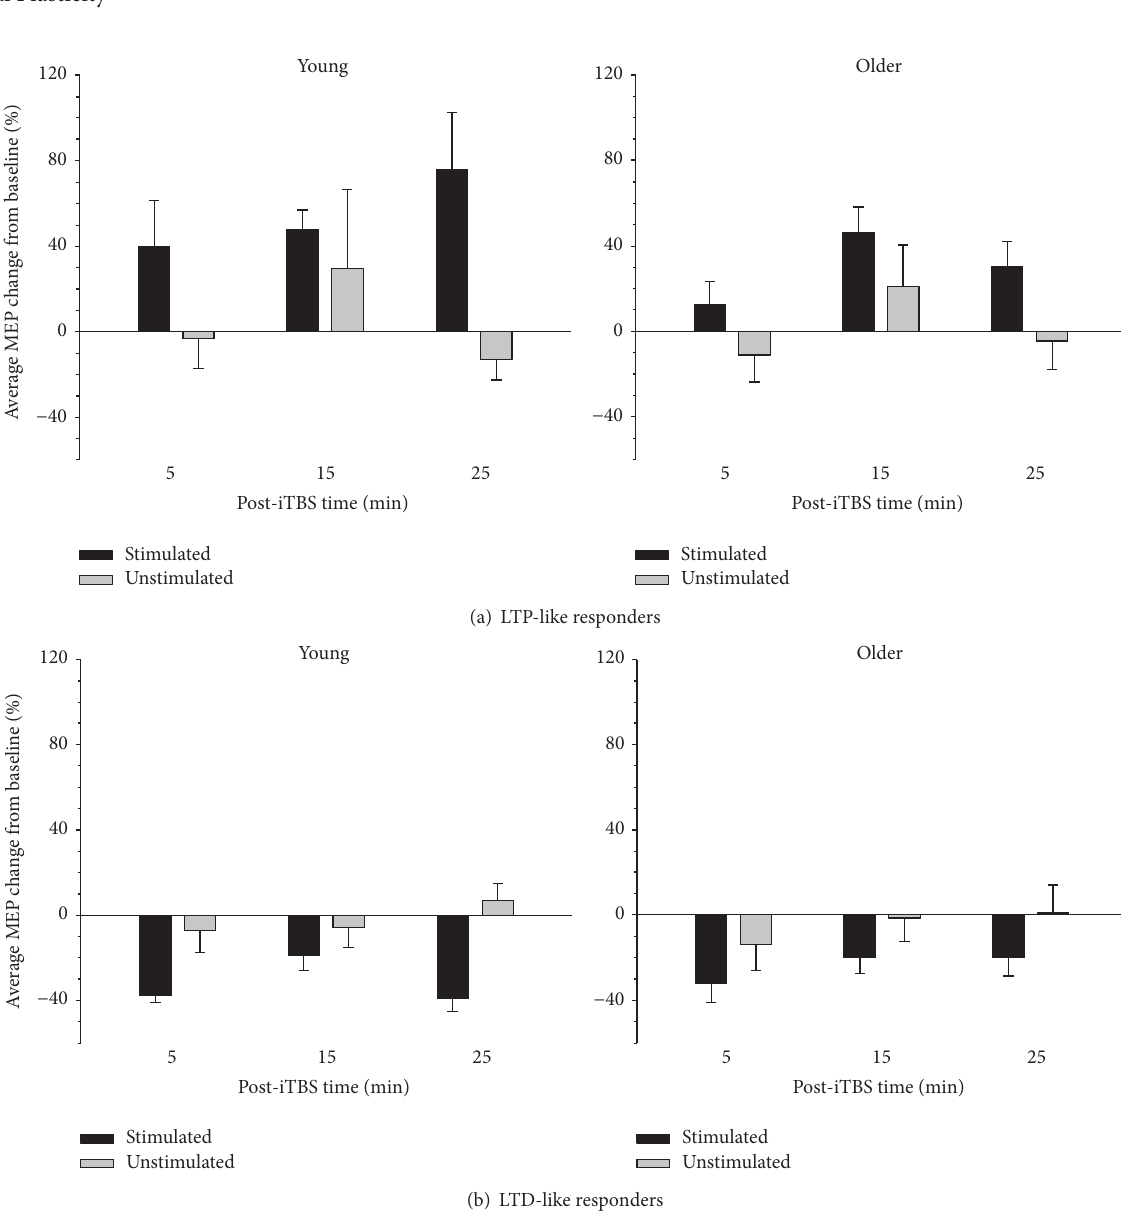
significant difference between 15 and 25 mins after ( 𝑡(39) =